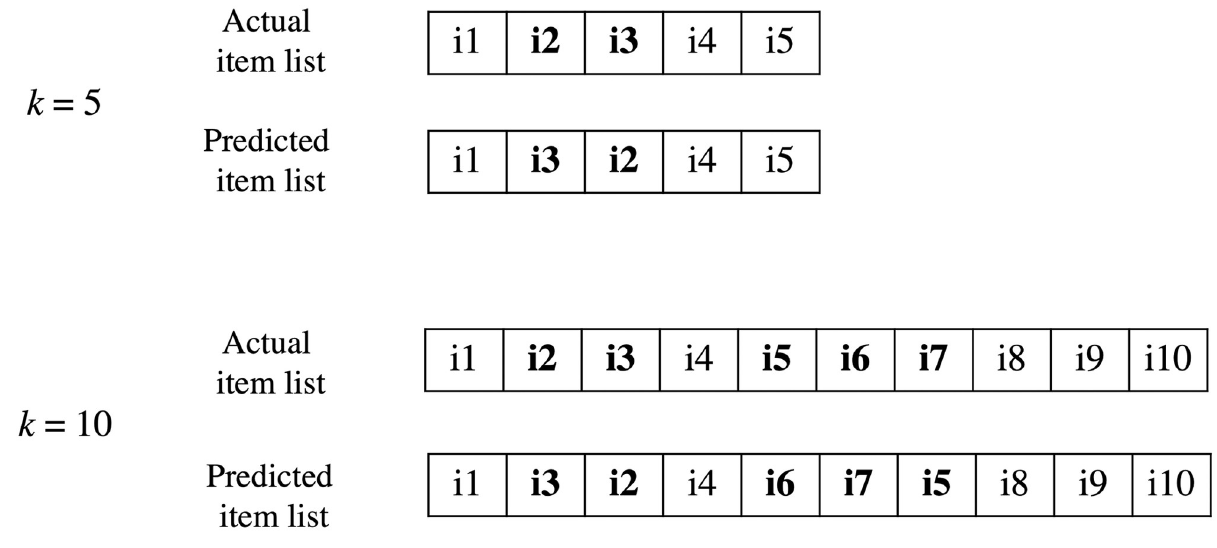
Fig 10. The example of comparing k